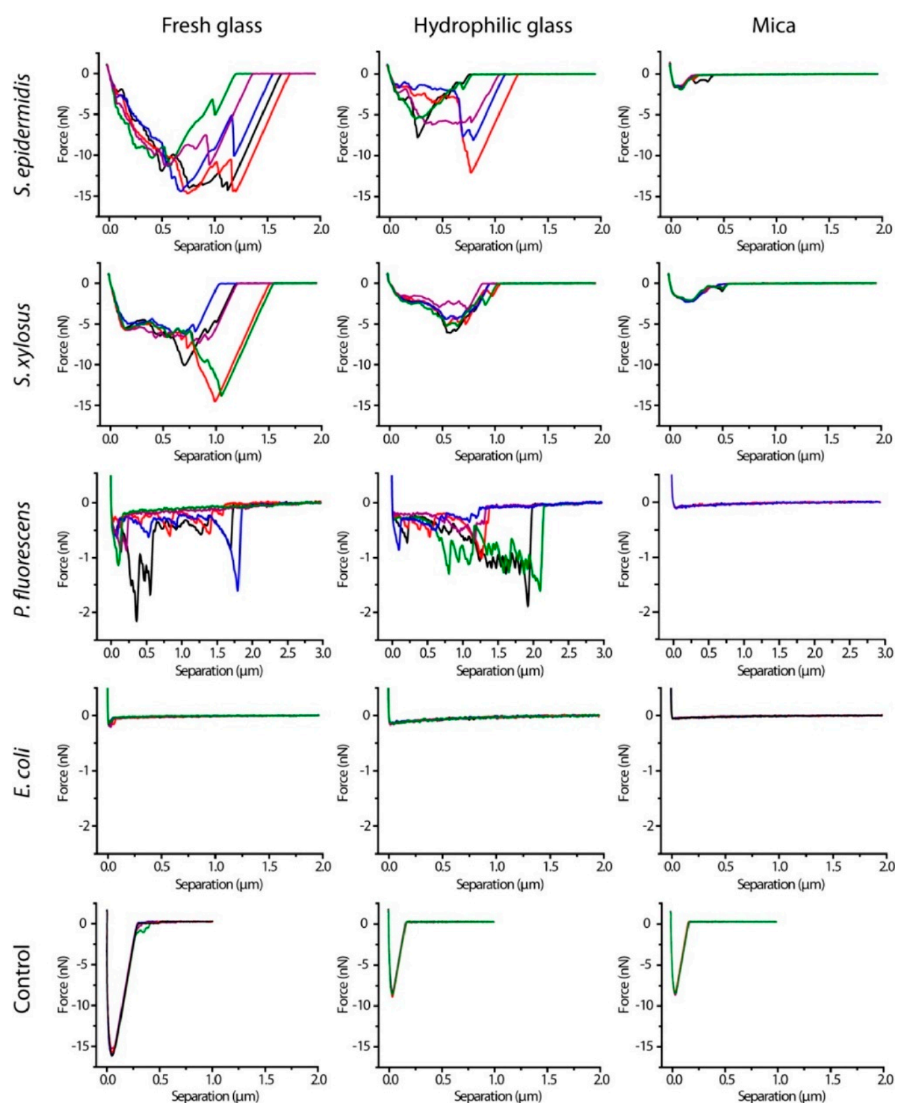
Figure 15. Representative retraction force curves of S. epidermidis , S. xylosus , P. fluorescens , and E. coli single-cell probes and control probes (Cell-Tak-coated cantilevers) on three surfaces after contact for 10 s (Figure reproduced with permission